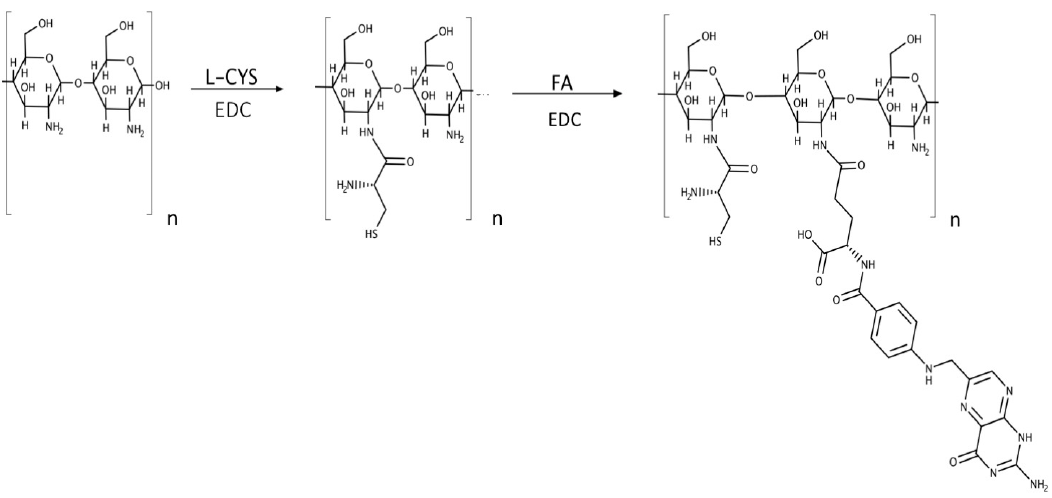
Figure 1. Synthesis route of folic-thiolated chitosan. Abbreviations: l -CYS, l -cysteine; EDC, 1-ethyl-3-(3-dimethyllaminopropyl) carbodiimide hydrochloride; FA, folic acid. Table 1. Amounts of reagents used ( ± 10%) for the synthesis of folic-thiolated chitosan (FTC) conjugates with di ff erent weight ratios of l -cysteine ( l -Cys) and results of the number of thiol groups and folic acid (FA) content obtained. EDC—1-ethyl-3-(3-dimethyllaminopropyl) carbodiimide hydrochloride; CHT—chitosan;